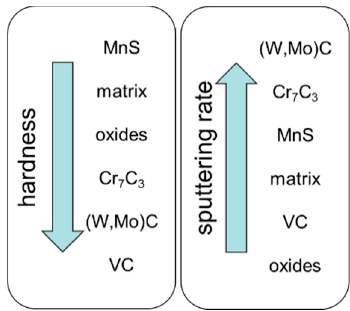
Figure 3. The total geometrical extension from the matrix level (either positive or negative) depends both on the differences in the polishing removal rate (hardness) and ion etching (sputtering) rate. When polishing tool steels, a very common problem is over-polishing, when the polished surface gets rougher with the polishing time. Over-polishing is associated with two surface phenomena: “orange peel” and “pitting”. The “orange peel” is a term used for a surface with randomly distributed smooth valleys and hills, which resembles the surface of an orange (hence the name). The formation of an orange-like surface is related to the clustered distribution of carbides in tool steel which can occur in the last polishing step if polishing is performed at too high of a pressure and prolonged time.